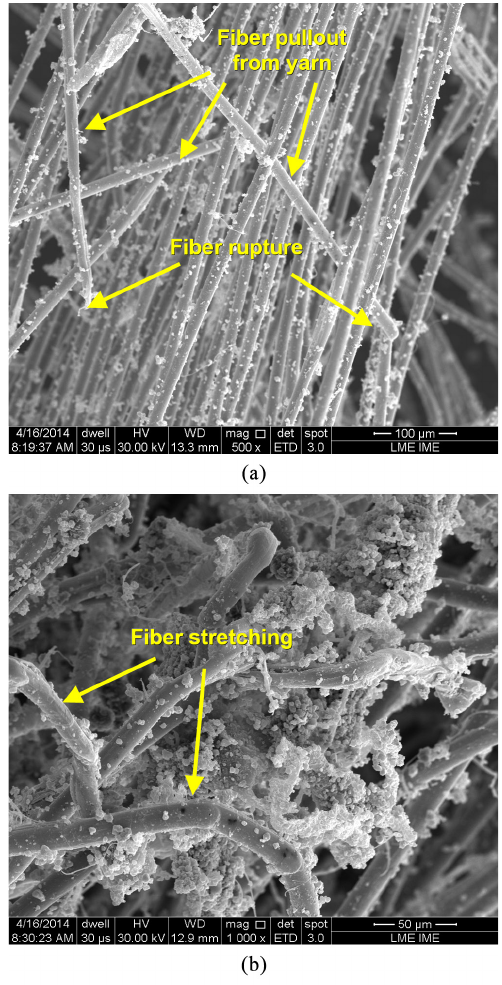
Figure 6. Damaged Kevlar ™ by fragments (projectile/ceramic) after the ballistic impact: (a) lower magnification and (b) higher